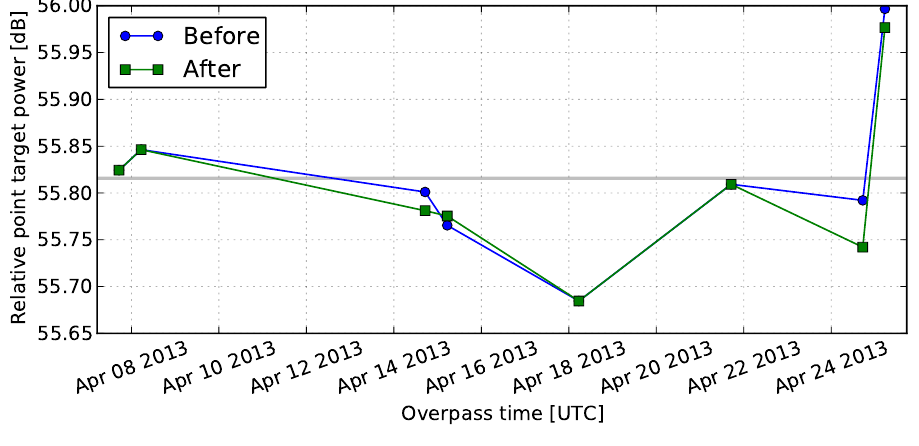
Visualization of the Kalibri transponder drift compensation with data from Table 4. For visual guidance, the gray line marks the sample mean of the data before transponder drift